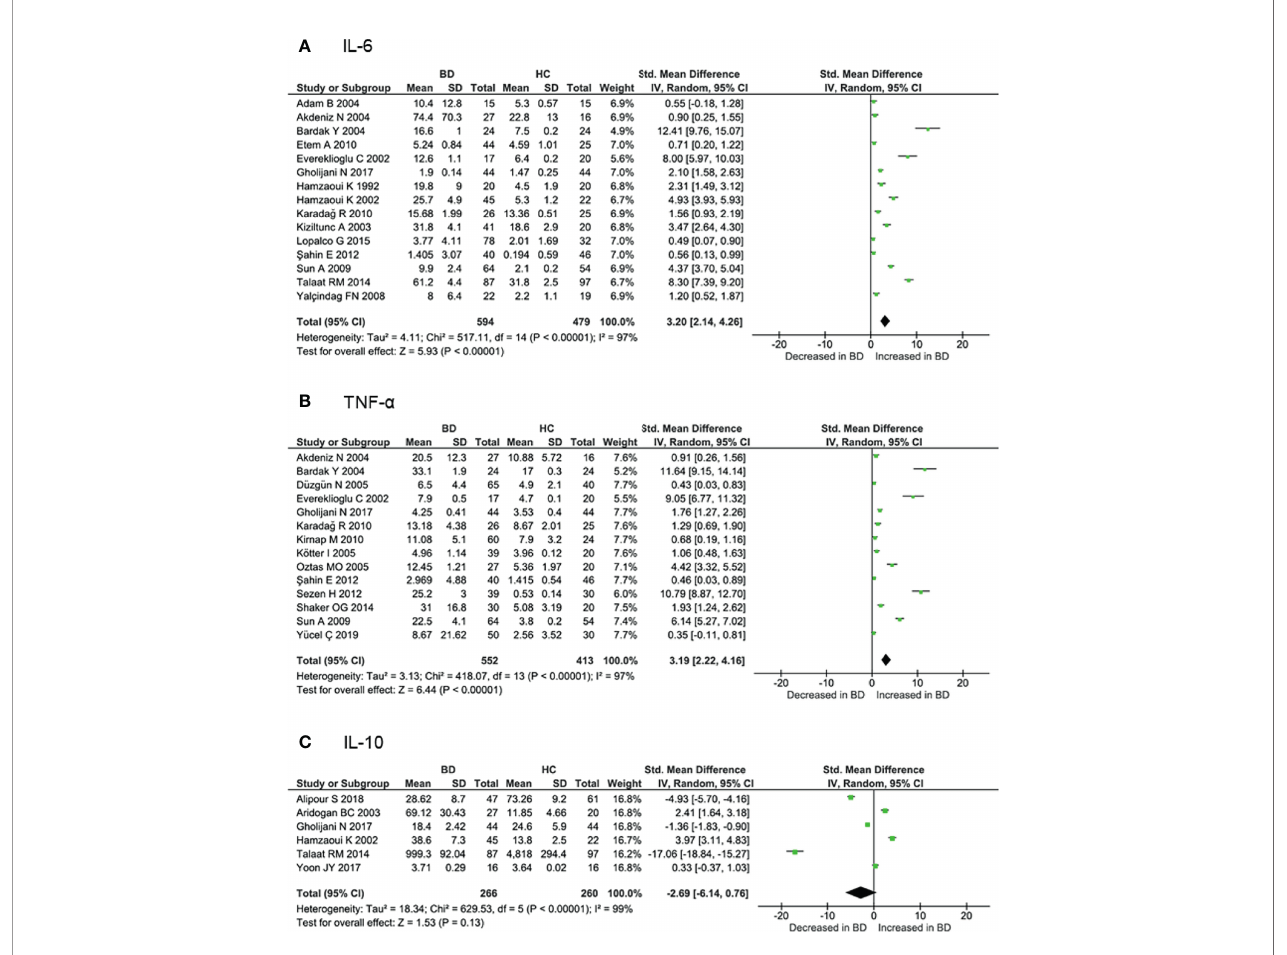
FIGURE 4 | Forest plot of the standardized mean difference of serum cytokine levels in BD patients compared with controls. (A) IL-6, (B) TNF- a , (C)